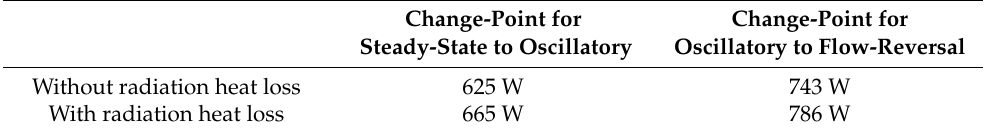
Table 1. Heater power at which NCL regimes move from steady-state to Oscillatory regimes, and oscillatory to flow-reversal regimes when radiation loss is ignored/included. Change-Point for Change-Point Steady-State to Oscillatory